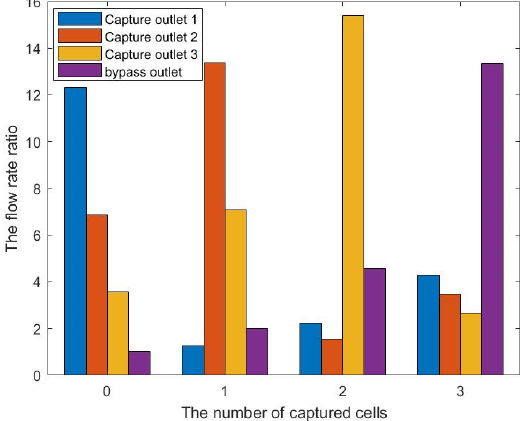
Figure 15. ( a ) The velocity field distribution and ( b ) pressure field distribution of 3D model with three captured cells.